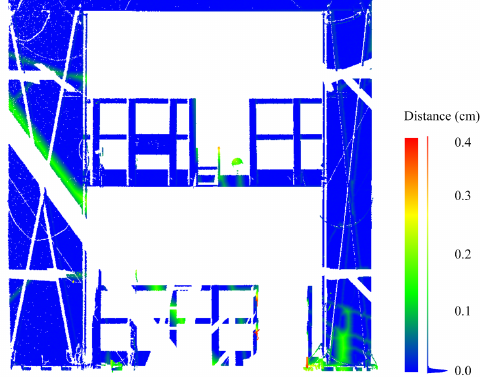
Figure 17: Point to point distance of the fine registration coarsely registered point clouds are 9 . 5 mm and 6 . 7 mm respec-